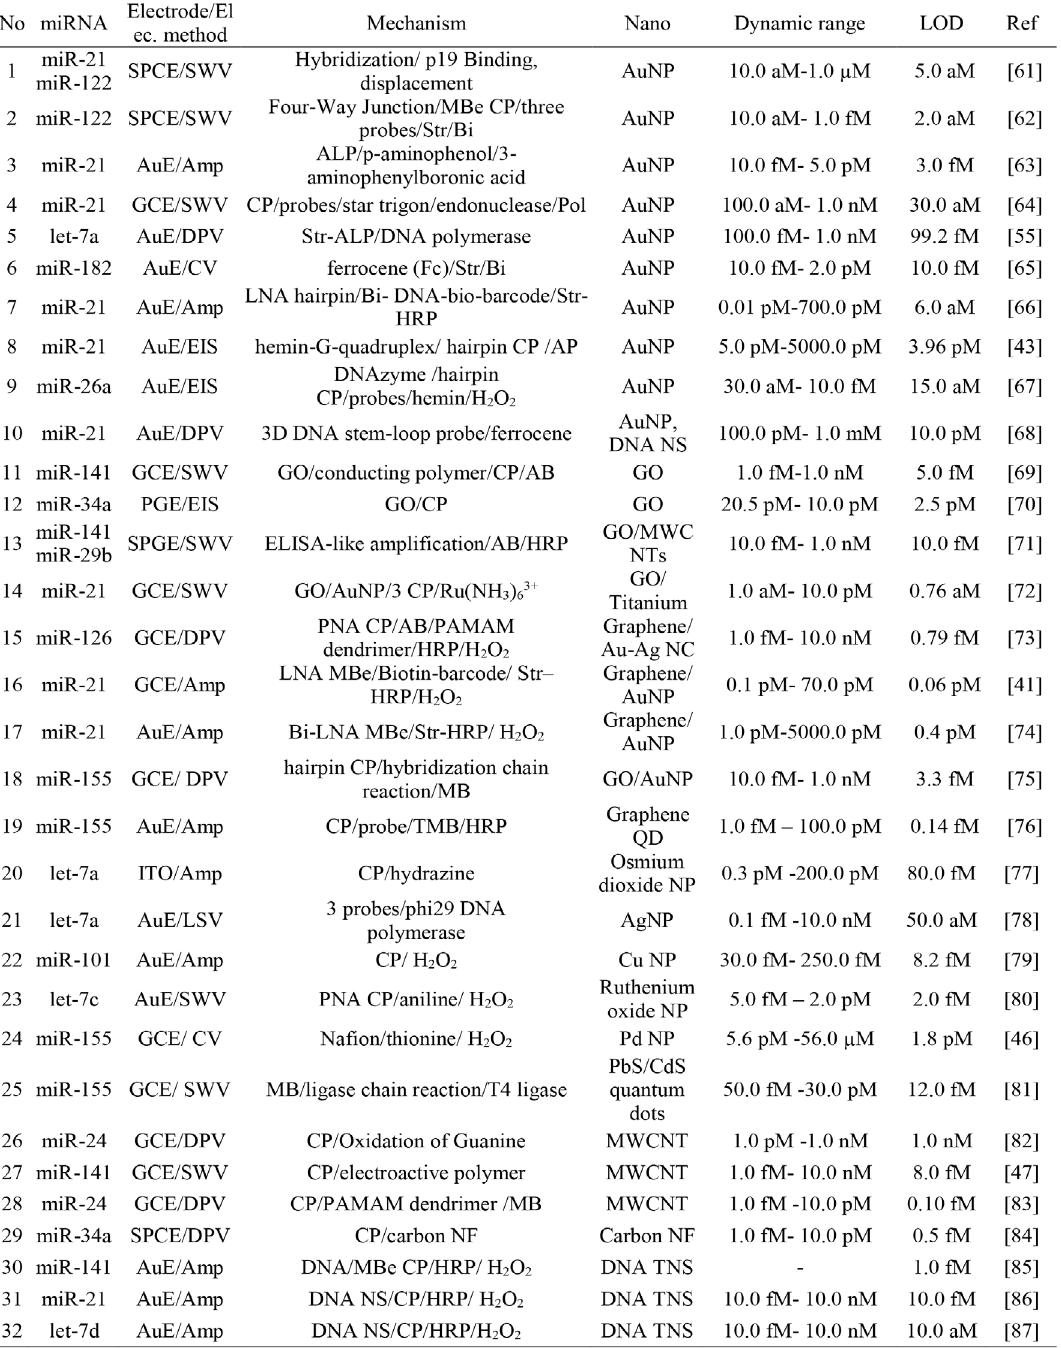
Table 1. Summary of recent electrochemical nanobiosensor components and performances.